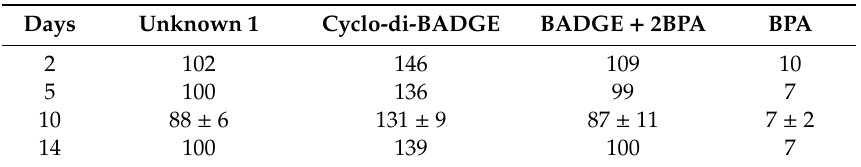
Table 2. Concentrations of tracked migrants from epoxy resins in in retorted cans containing Miglyol 812 ® food simulant during the migration test at 60 ◦ C. Results expressed in µ g / dm 2 assuming that 1 Kg is in contact with 6 dm 2 of the surface of the polymer.